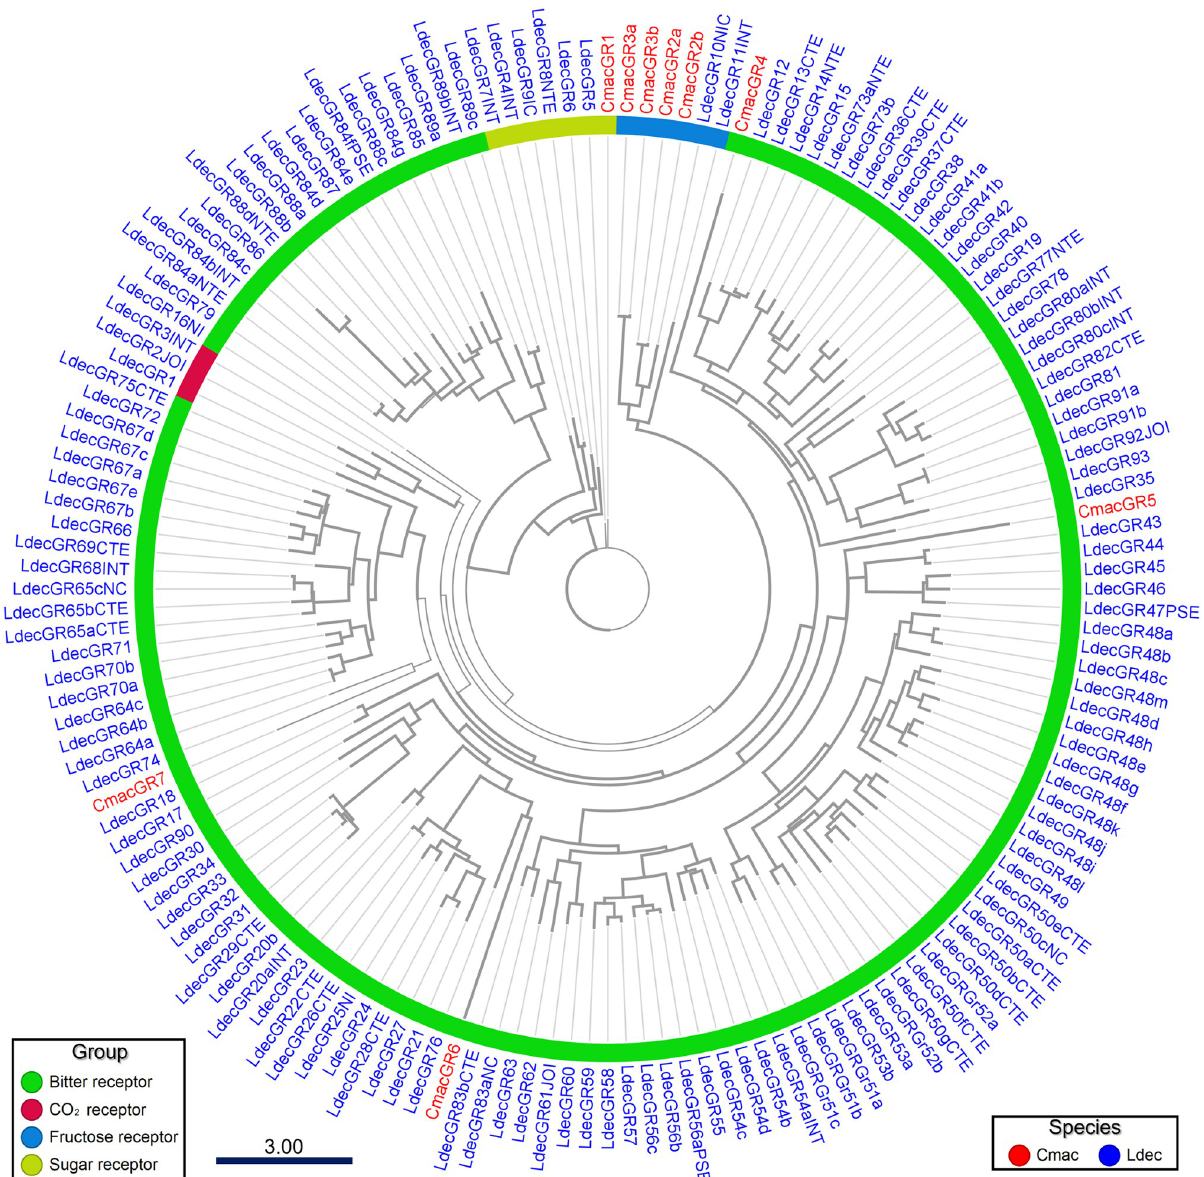
Fig 2. Maximum-likelihood phylogenetic tree of putative Callosobruchus maculatus gustatory receptors (GRs) with Leptinotarsa decemlineata (Ldec) GR sequences. Thick nodes are supported by a bootstrap value > 60%. The rate of amino-acid substitutions per site is shown at the scale bar.